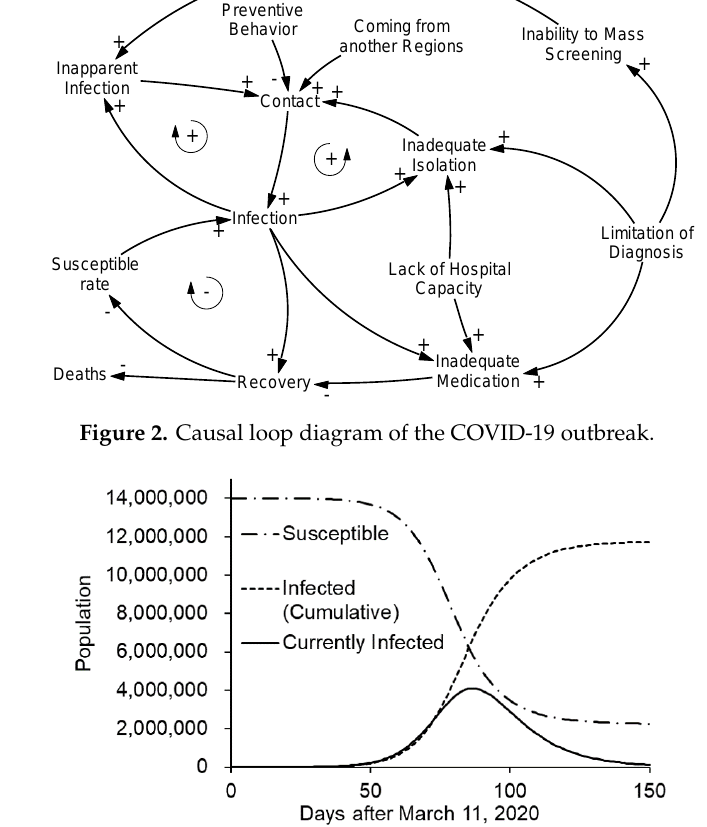
Figure 3. Simulation of the COVID-19 outbreak without intervention (Tokyo case).